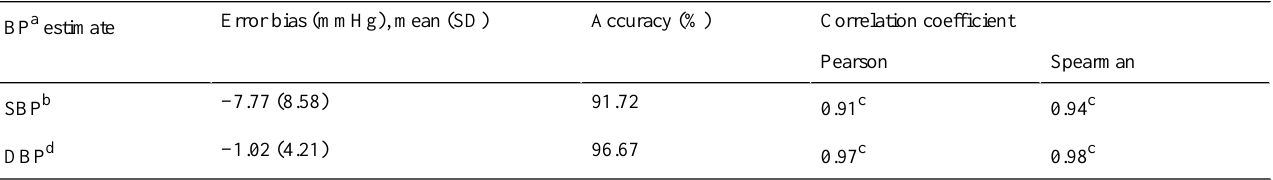
Table 2. Accuracy and precision of predicted values with respect to reference blood pressure